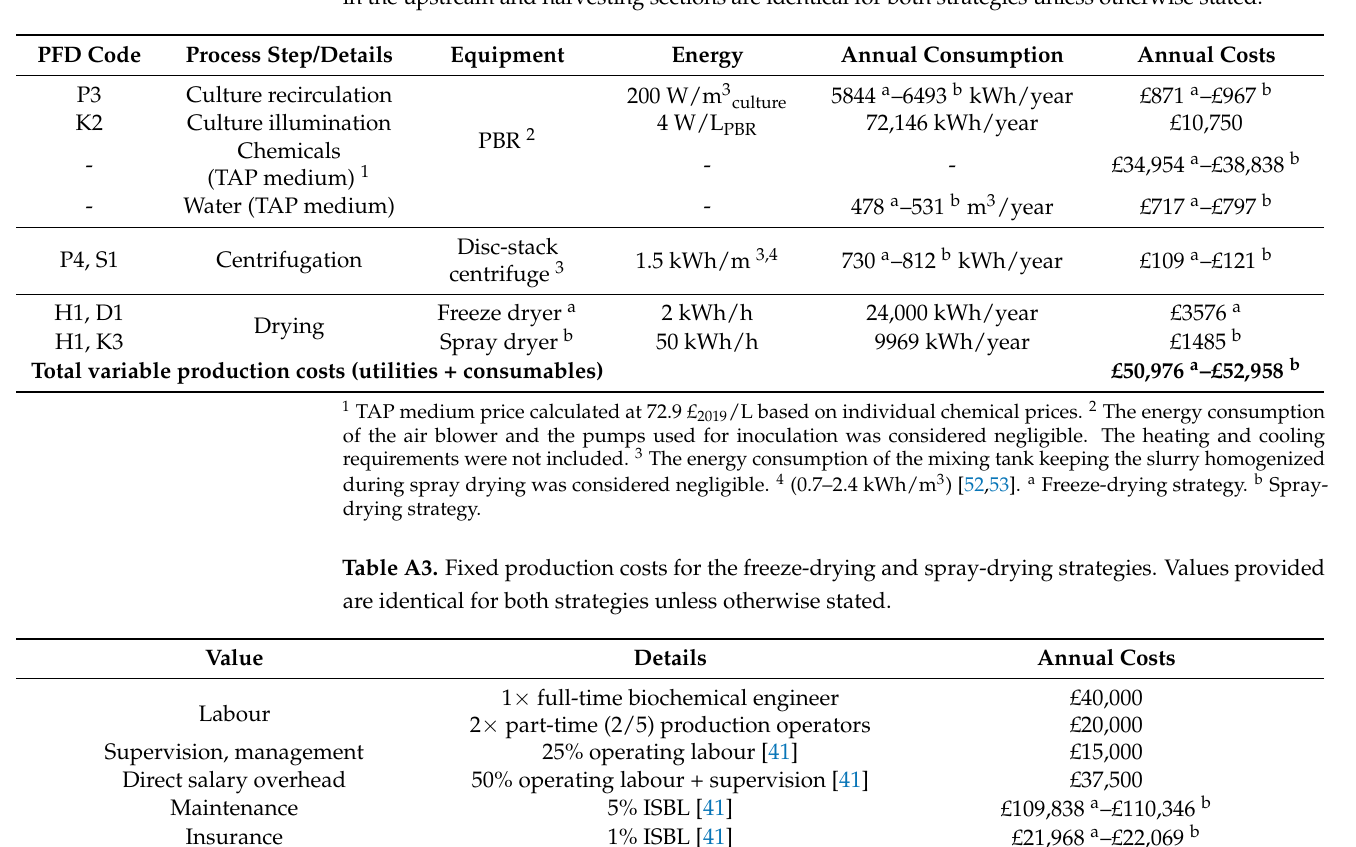
Table A2. Variable production costs for the freeze-drying and spray-drying strategies. Values provided in the upstream and harvesting sections are identical for both strategies unless otherwise stated.